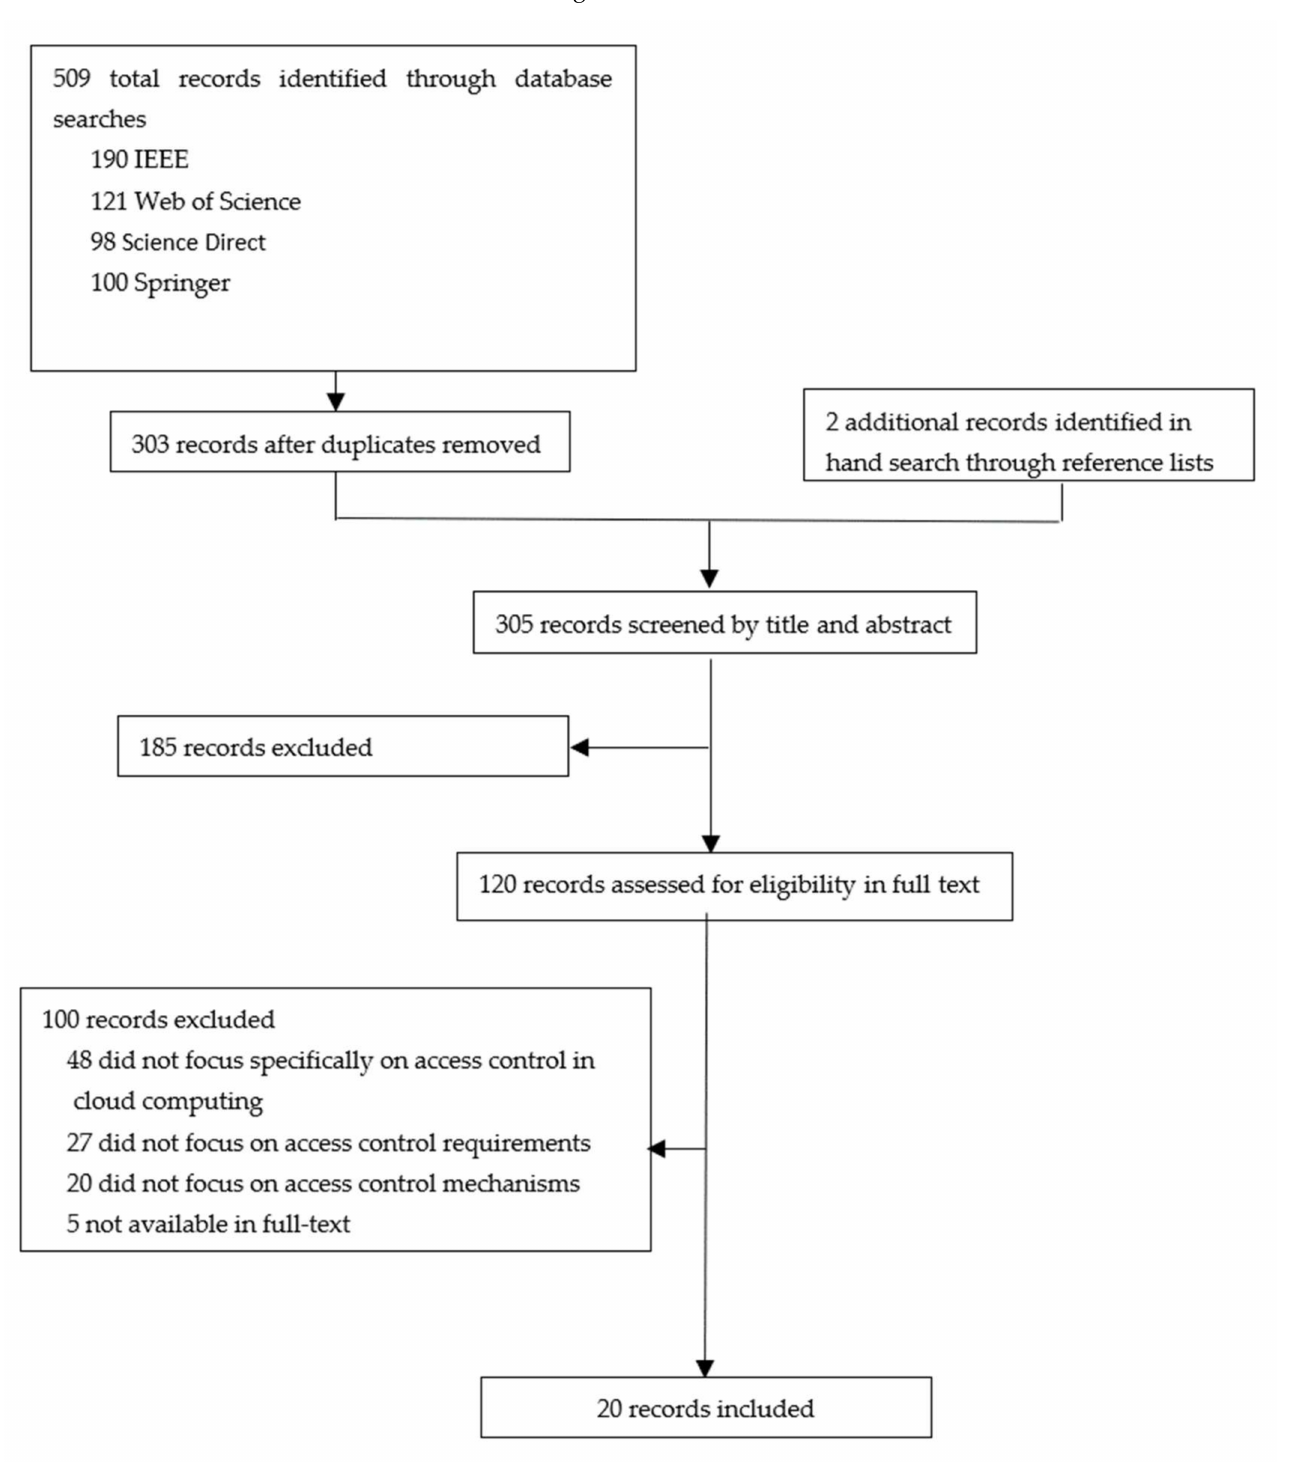
Figure 1. Flowchart of the review